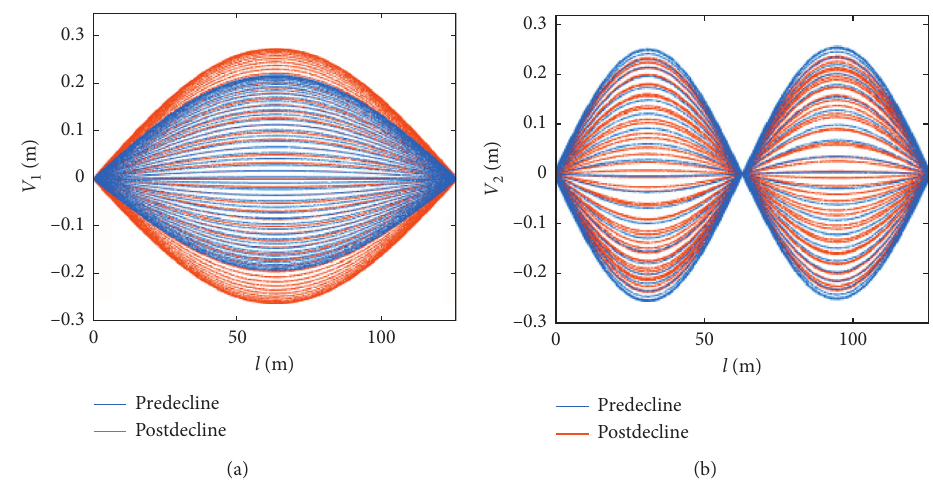
Figure 5: Galloping profiles. (a) 1 st in-plane mode. (b) 2 nd in-plane mode.